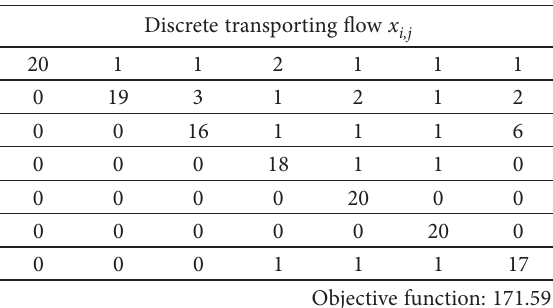
Fig. 2. Objective function values for test problems Table 4. Best obtained discrete solution for the 7×7 test problem with cost function A